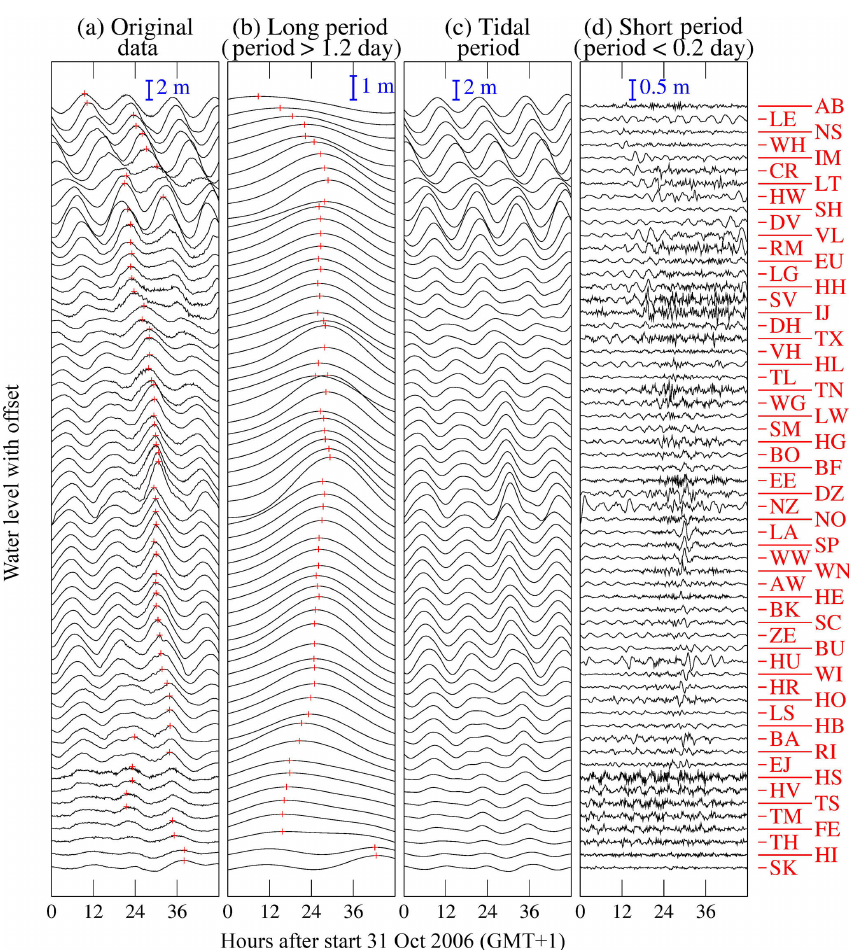
Figure 2. (a) Original tide gauge time series and frequency band reconstructions for the (b) storm surge, (c) tidal, and (d) short period components. The red plus symbols mark the maximum of the 48h time series for (a) and (b)